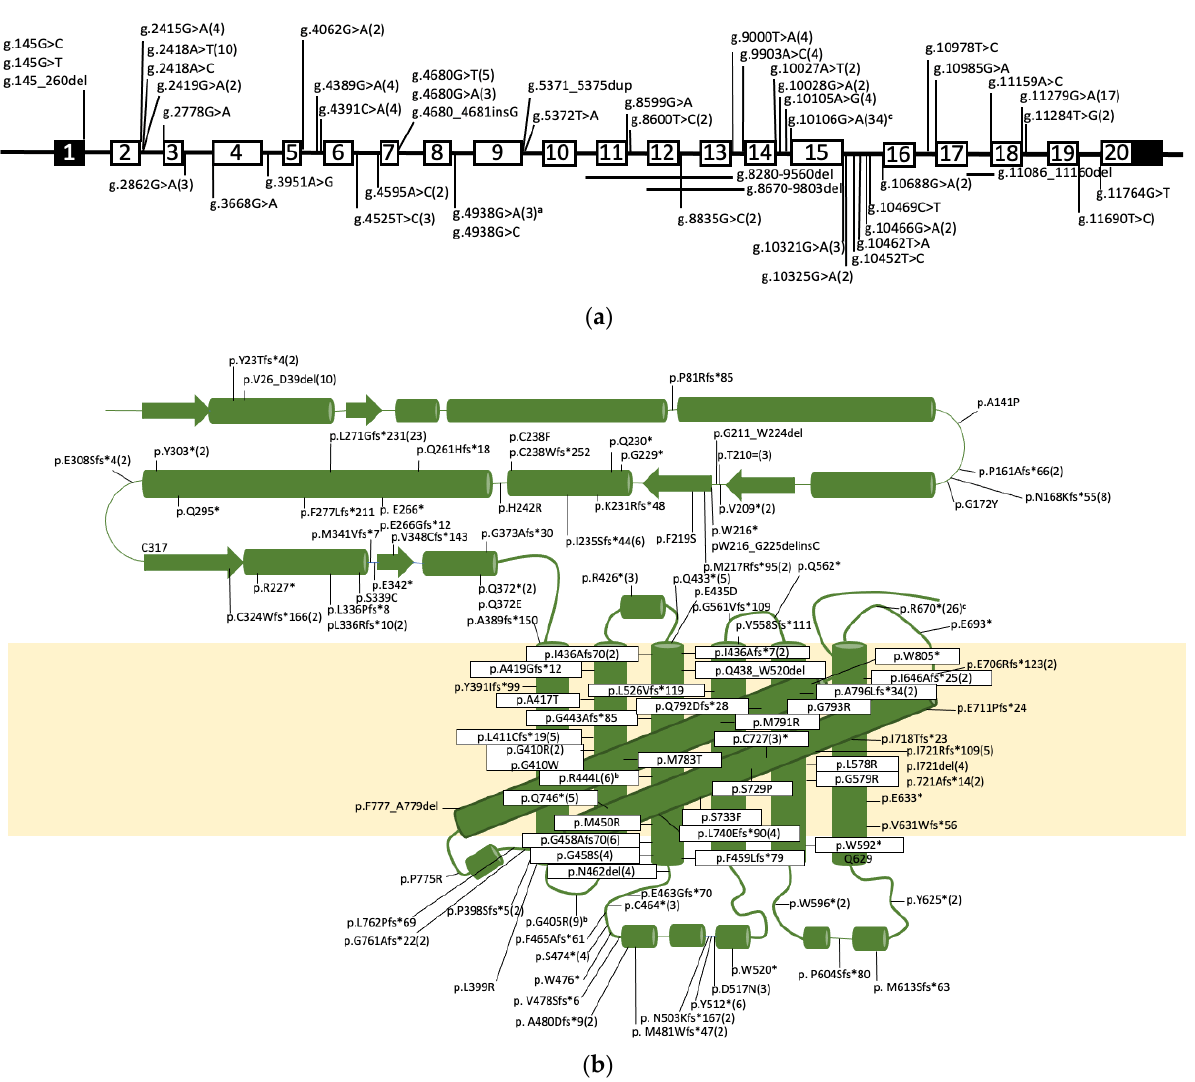
Figure 3. Mutations in TCIRG1 cause malignant autosomal recessive osteopetrosis (Table 2). ( a ) Splice-site mutations in the introns of TCIRG1. ( b ) Missense and small deletion mutations in the a3 isoform. a Founder effect in the Chuvashiya and Marians population; b founder effect in the Costa Rica population; c founder effect in the Flanders population.